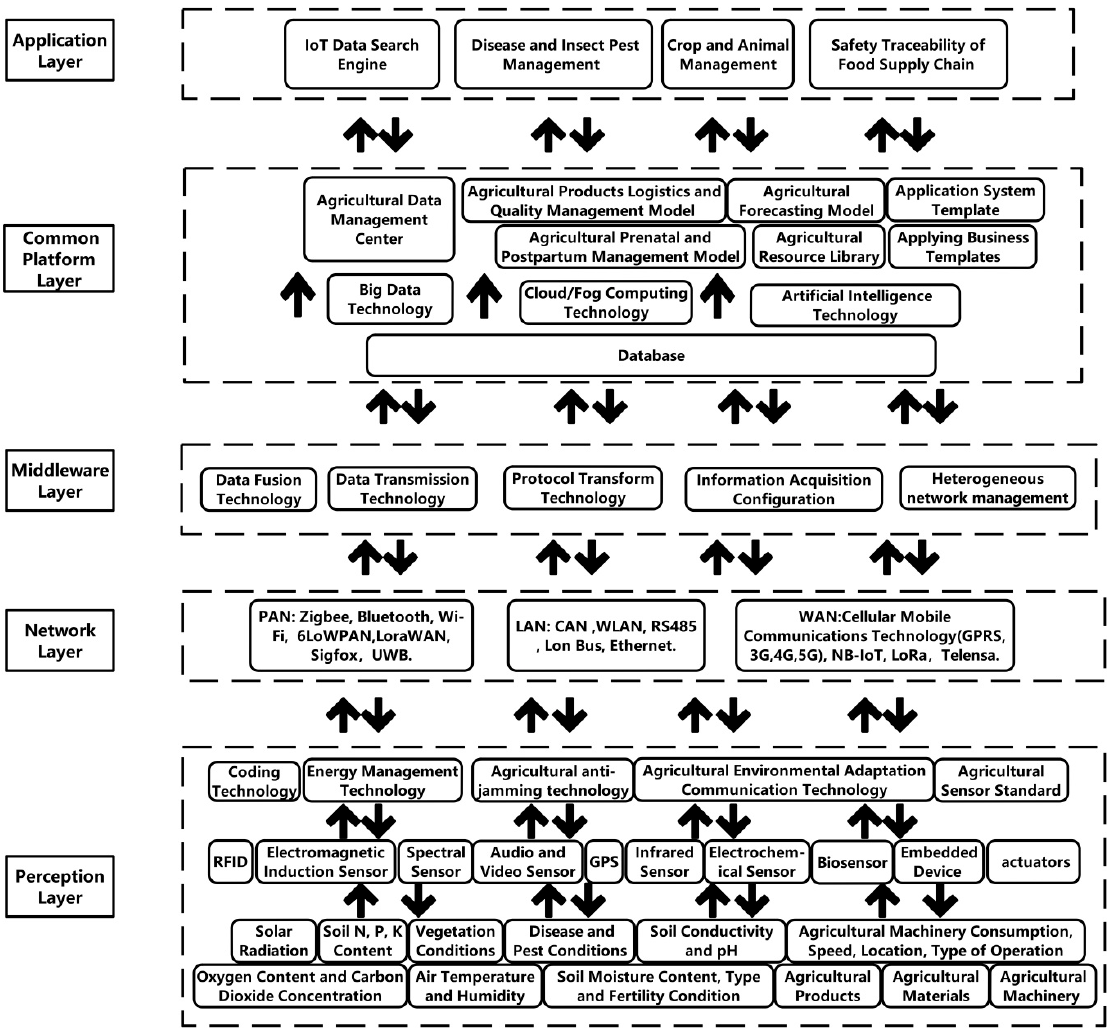
Figure 5. Structure of IoT in protected agriculture [22].